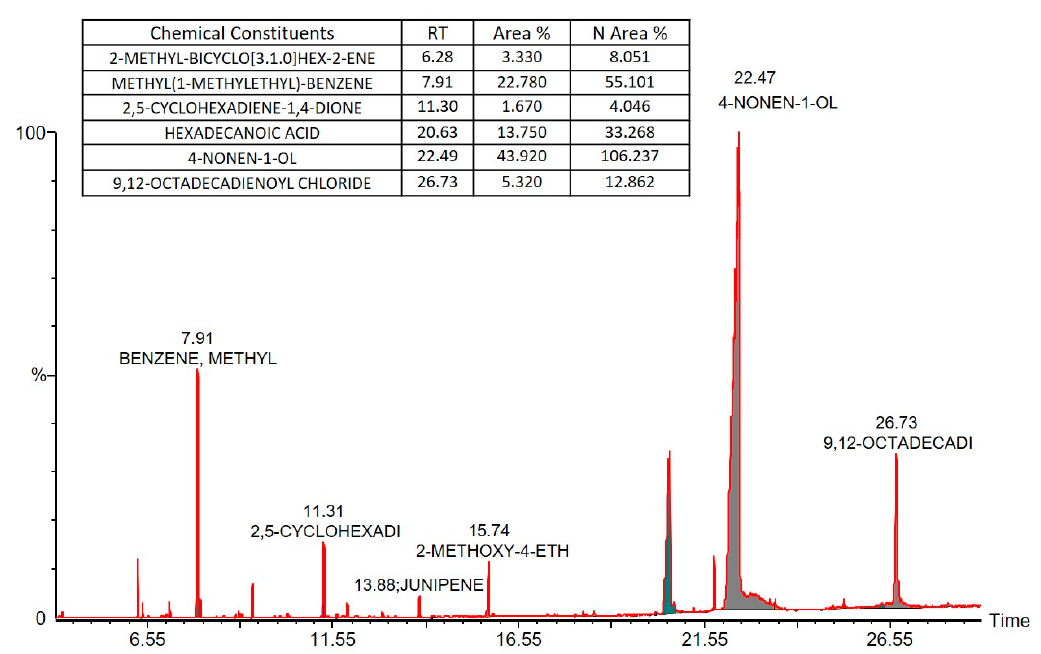
Figure 2. GC–MS chromatogram of black seed oil extract and the list of the major chemical